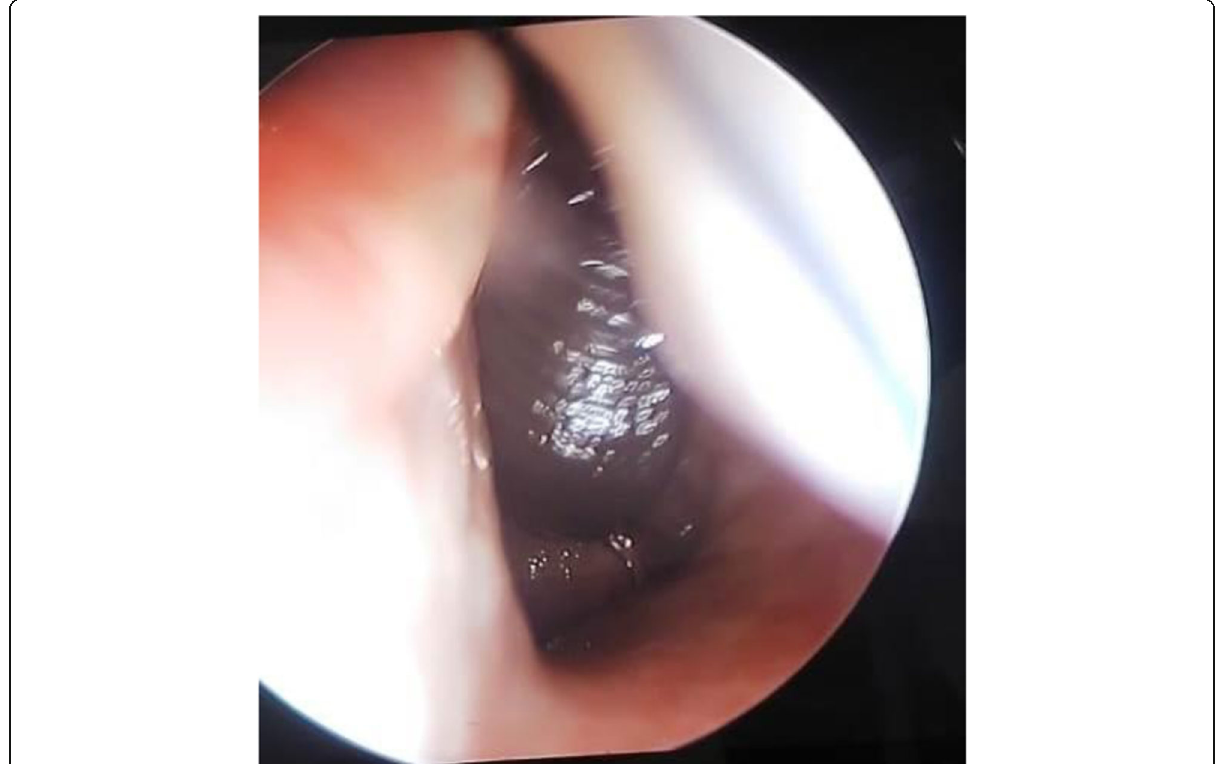
Fig. 1 Endoscopic view of nasopharynx depicting animate foreign body